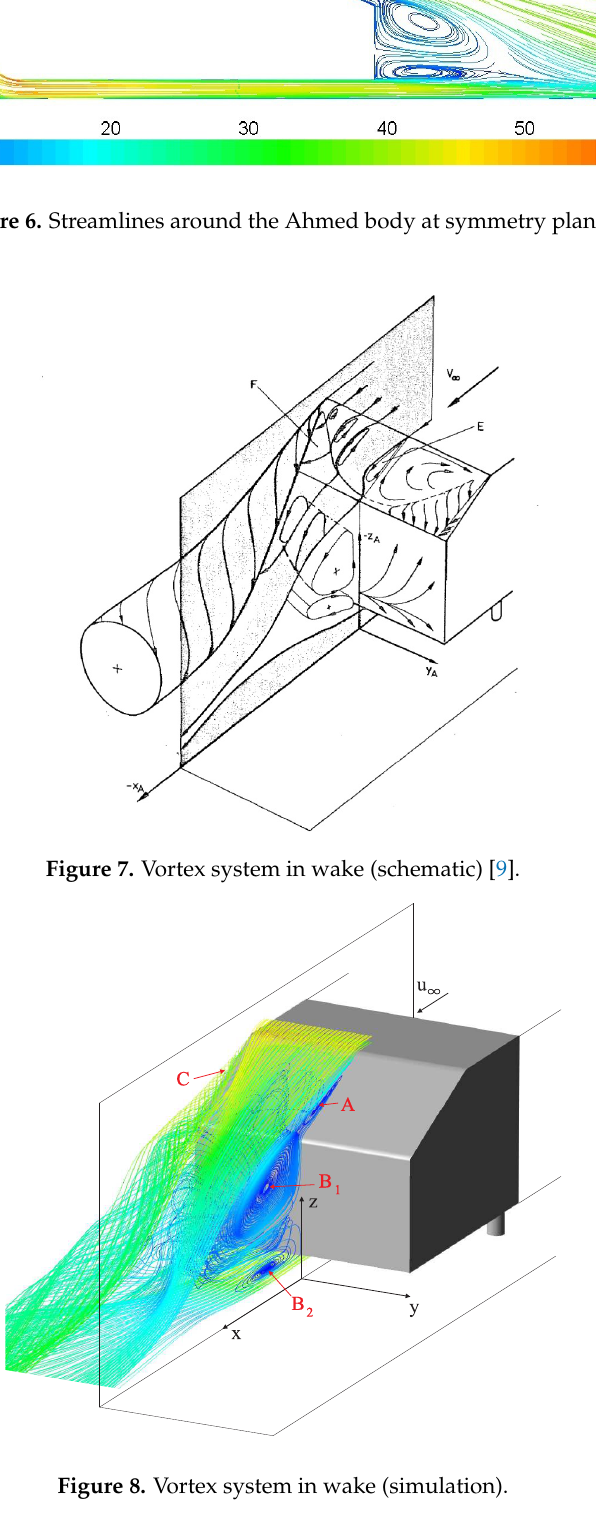
Figure 8. Vortex system in wake